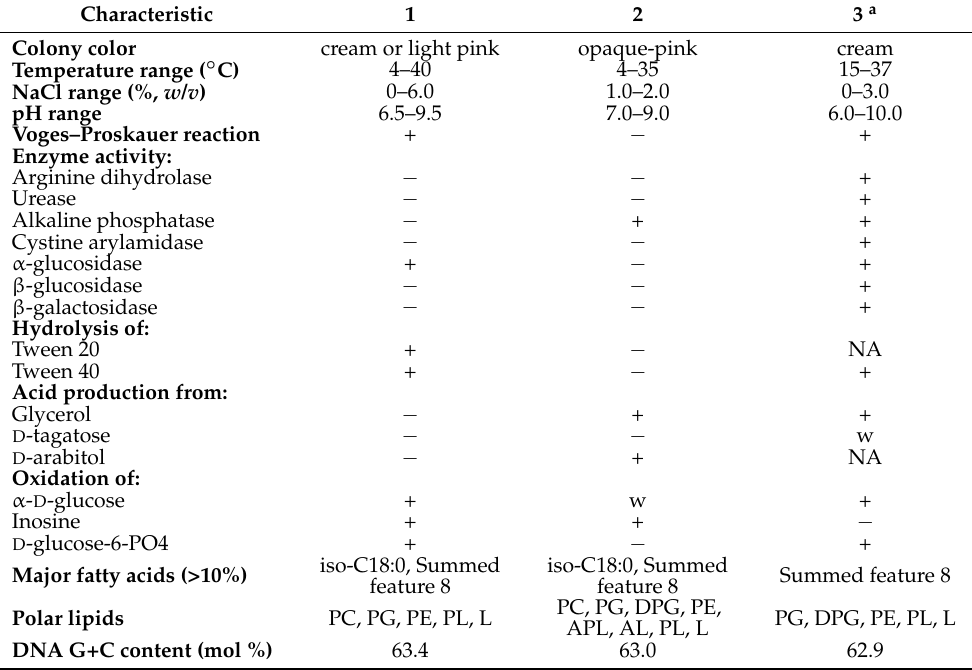
Table 3. Differential characteristics between strain XJSP T and related species. Characteristic 1 2 3 a Colony